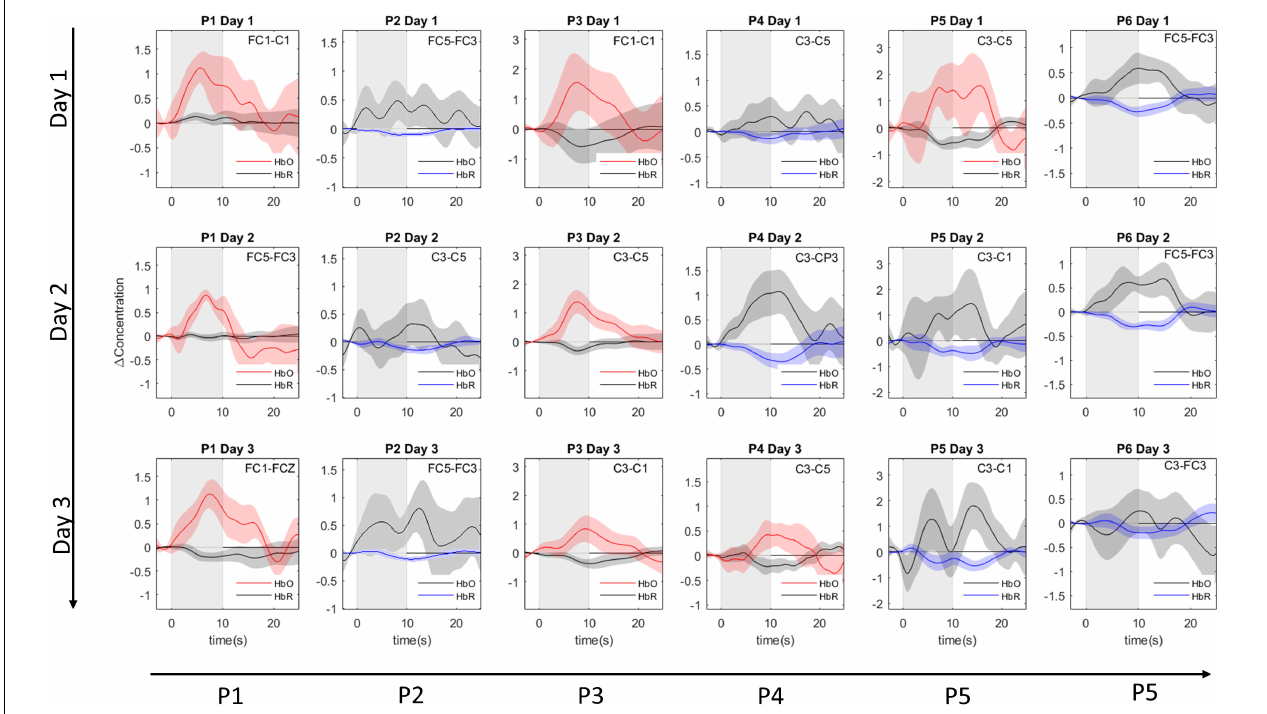
FIGURE 4 | Subject specific event-related averages. Event-related averages for the most-informative channel-by-chromophore combination for each participant (columns) in each session (rows). The shaded rectangle represents the mental task duration (10 s). The event-related averages are depicted from 3 s before until 15 s after mental task performance. The selected channel can be read in the right upper corner. Colored lines depict the average concentration change of the selected chromophore: red for oxygenated hemoglobin (HbO) and blue for deoxygenated hemoglobin (HbR). For completeness, gray lines depict the chromophore counterpart belonging to the most-informative channel. The shaded area around the mean average line represents the 95% confidence interval of the mean.